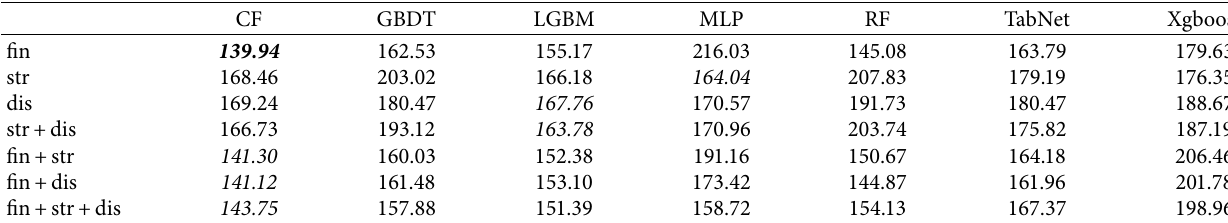
Table 2: Te performances of features and models in the historical maximum return regression task.